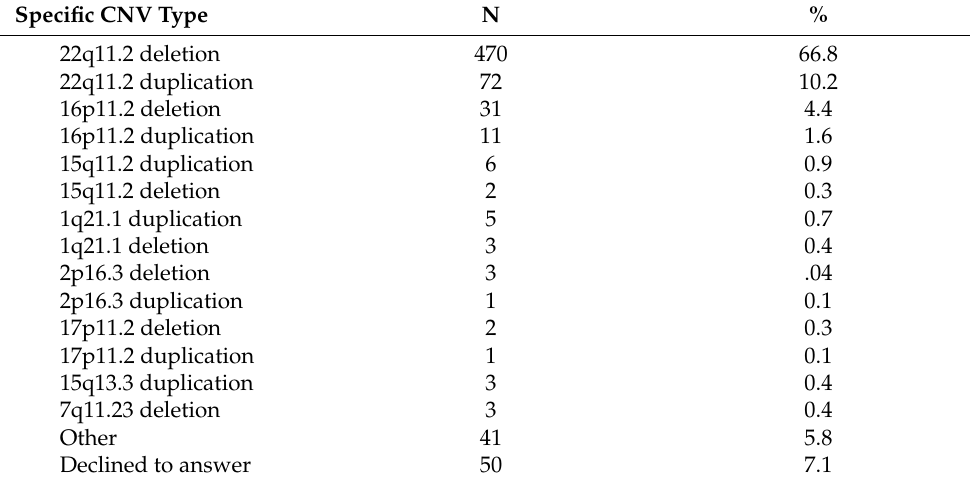
Table 2. Represented Rare Copy Number Variants